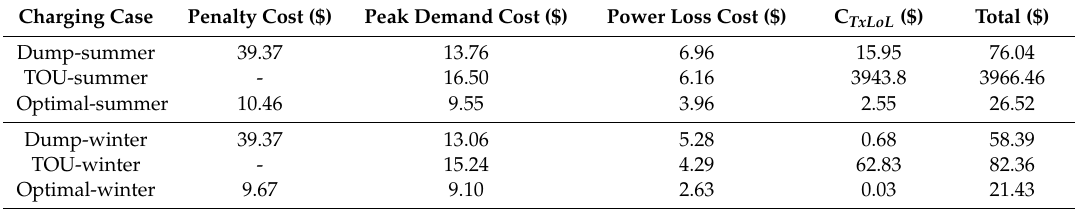
Figure 10. Efficiency improvement of the proposed method based on the cost reduction; peak demand cost ( a ), power loss cost ( b ), transformer loss of life cost ( c ) and the total cost ( d ). Table 6. Economic cost evaluation.